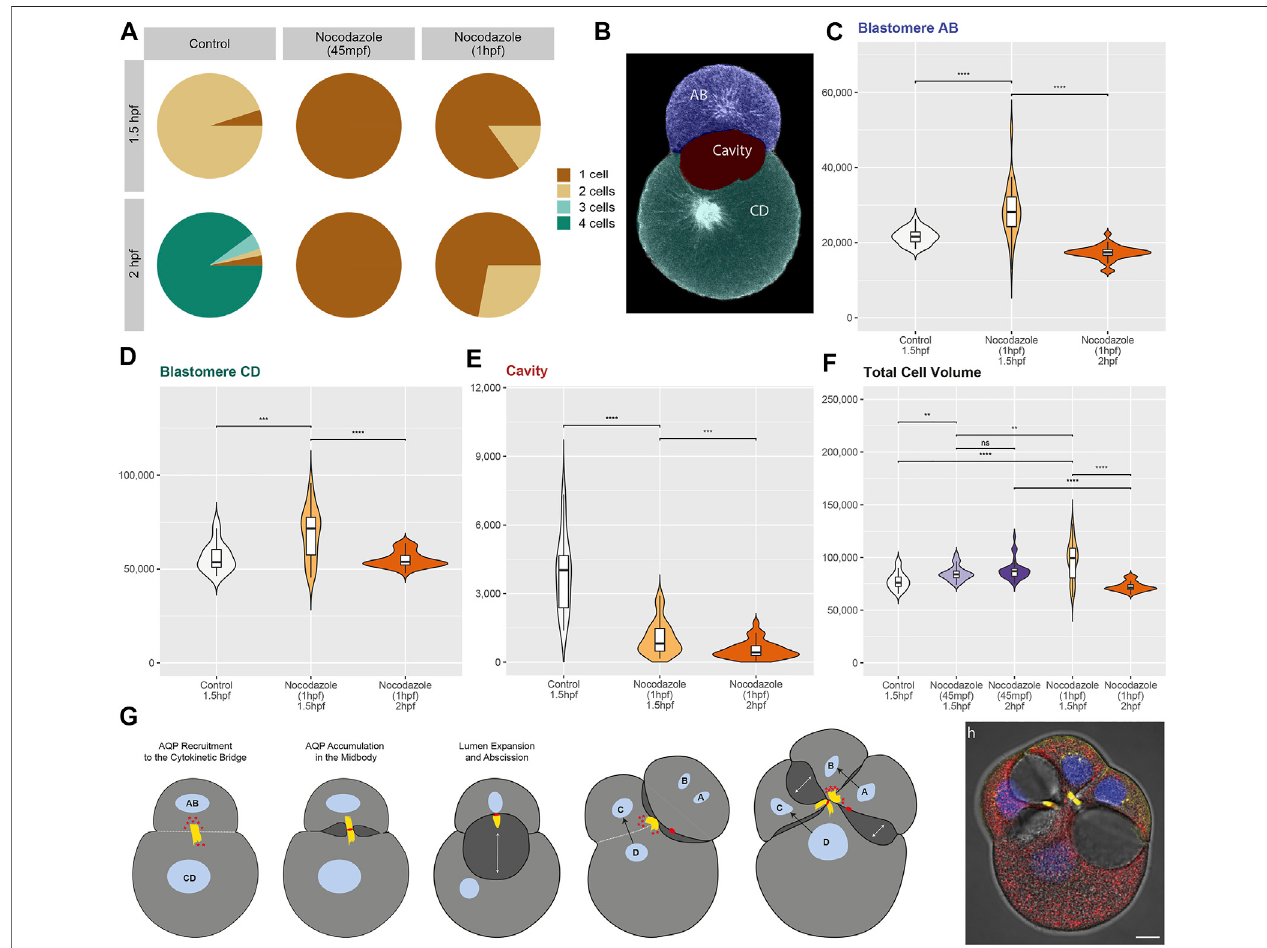
FIGURE4| Statistical analyses ofnocodazole phenotypes and model ofaquaporin functionin Dreissena rostriformis . (A) Pie charts depictthe percentage ofone-, two-,three-andfour-cellstagesforembryosat1.5and 2hpfthatwereexposedtodifferenttreatment conditionsasindicated. (B) Singleopticalsectionwithareasused for image segmentation and volumetric measurements colorized. (C – F) Violin plots illustrate volume distributions in μm³ for the AB blastomere (C) , the CD blastomere (D) , the cleavage cavity (E) and the total cell volume (i.e., AB + CD volumes) (F) of embryos exposed to different treatment conditions. For nocodazole treatments from 1hpf, only embryos with a two-cell stage phenotype were analyzed. To compare different conditions, a two-sided Wilcoxon rank-sum test was used with several p -value thresholds (****p = < 1e-04, ***p = < 0.001, **p = < 0.01, *p = < 0.05, n. s p > 0.05). Comparisons were only made between embryos that are either at the same stage, have the same number of blastomeres or were exposed to the same treatment. (G) Schematic representation of the here-proposed model of lumenogenesis. Recruitment of AQP (red) via a cytokinetic bridge (yellow) to the midbody leads to the formation of cleavage cavities (dark grey). Black arrows indicate the direction of blastomere division and double-headed white arrows indicate the direction of cleavage cavity expansion. (H) Overlay of a bright fi eld image and a maximum intensity projection of a control embryo at 2 hpf labeled for Dro-lt-AQP1 immunoreactivity (red), acetylated/tyrosinated alpha-tubulin immunoreactivity (yellow) and Hoechst nuclear staining (blue). Scale bar, 10